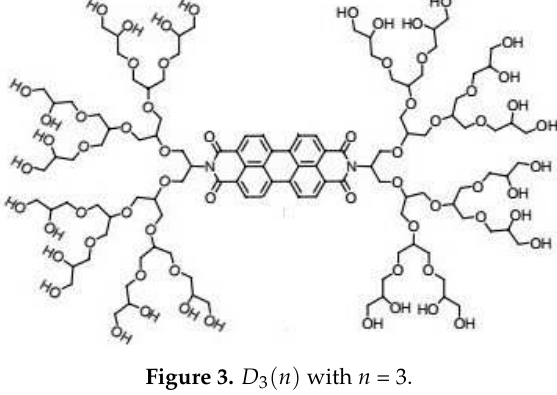
Figure 3. D 3 ( n ) with n =